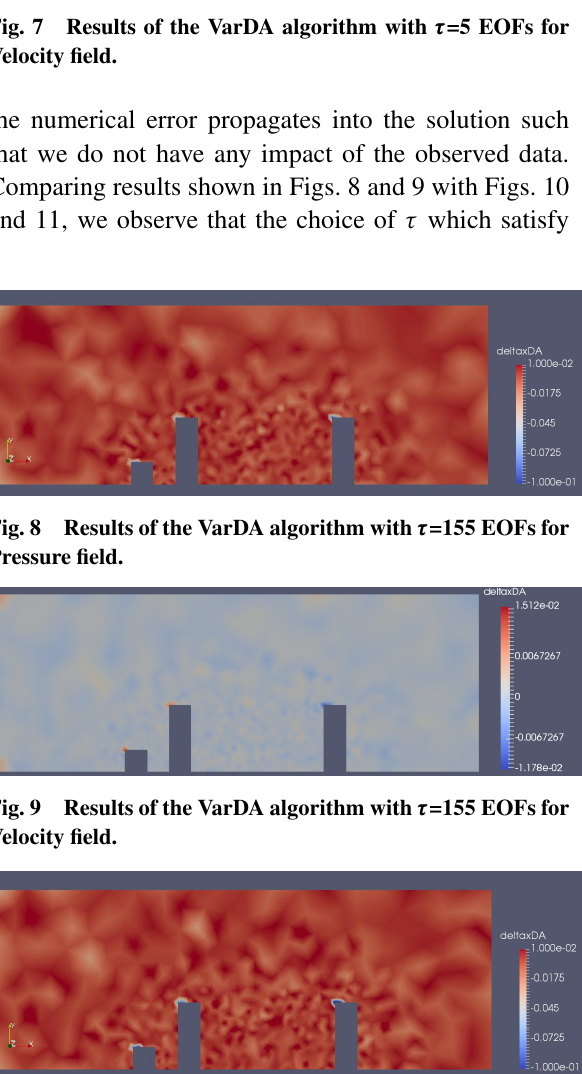
Fig. 10 Results of the VarDA algorithm with (cid:28)(cid:28)(cid:28) =295 EOFs for Pressure